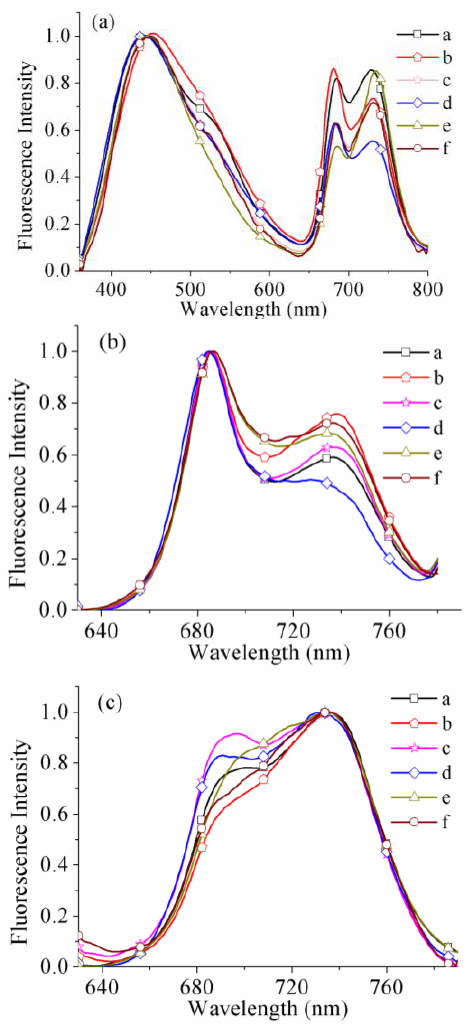
Figure 2. The normalized LIF spectra of the eight plant species were induced by different excitation wavelengths. (a) C. yedoensis, (b) C. kotoense , (c) S. babylonica Linn. , (d) C. dielsiana , (e) I. chinensis Sims , (f) M. denudata Desr.